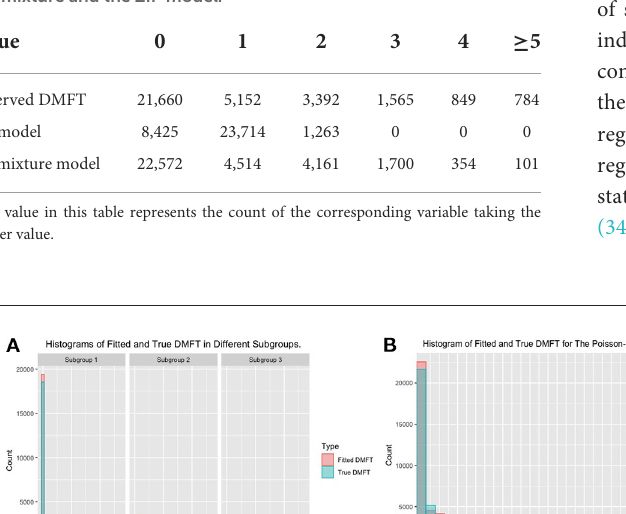
TABLE 3 Count for observed and fitted values of DMFT by the Poi-mixture and the ZIP model.